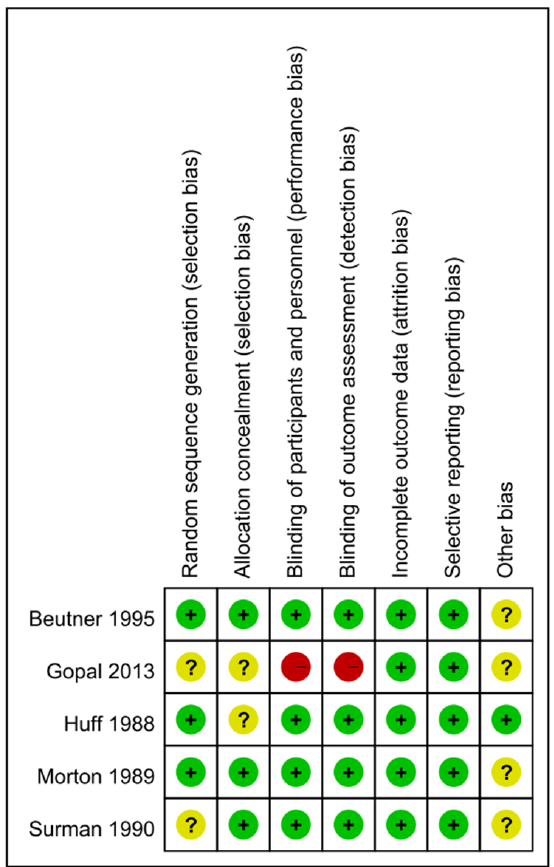
Figure 2. Summary of the assessment of the risk of bias.